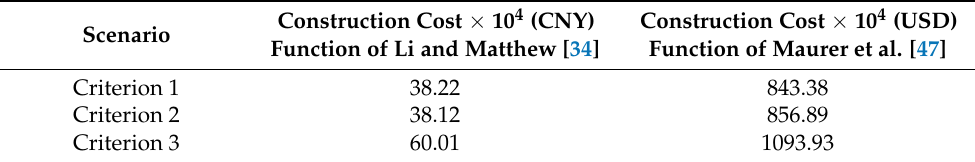
Table 7. Construction cost for each criterion in the benchmark proposed by Duque et al. [45].